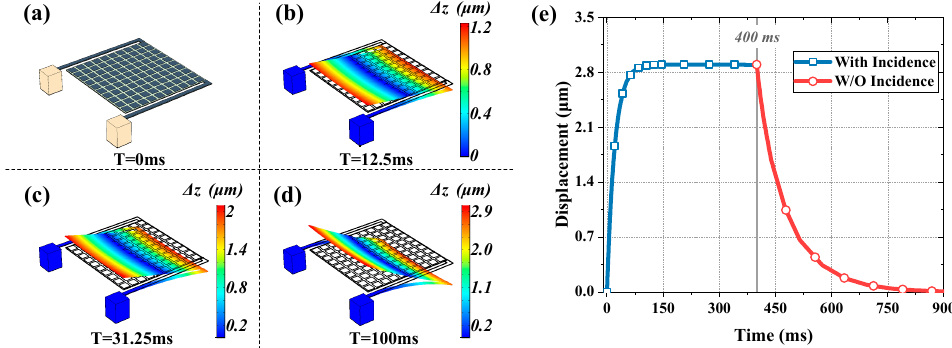
Figure 9. The simulated response process of detector under 100 nW incidence at 3.4 THz. Parts ( a – d ) corresponding to the deformation states of detector after irradiation of terahertz wave at 0ms, 12.5ms, 31.25ms and 100ms, respectively. Part ( e ) is the displacement of detector that changes over time.